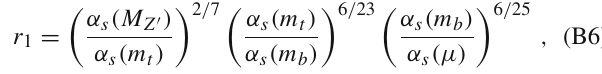
f T , defined in m D + m P f +